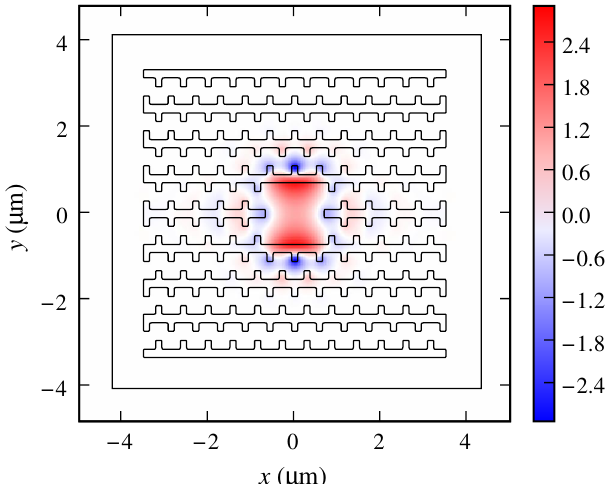
FIG. 8. The accelerating field in the focusing structure modi- fied to suppress the octupole moment. As in Fig. 4, the quantity plotted here is the accelerating field seen by a speed-of-light particle, averaged over a photonic crystal lattice period.